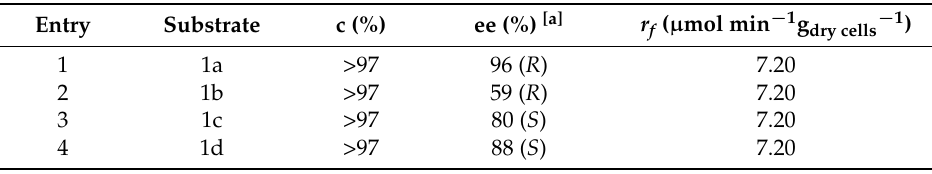
Table 2. Continuous enantioselective oxidation of achiral 2-substituted 1,3-diols 1a–d (24 mM) with